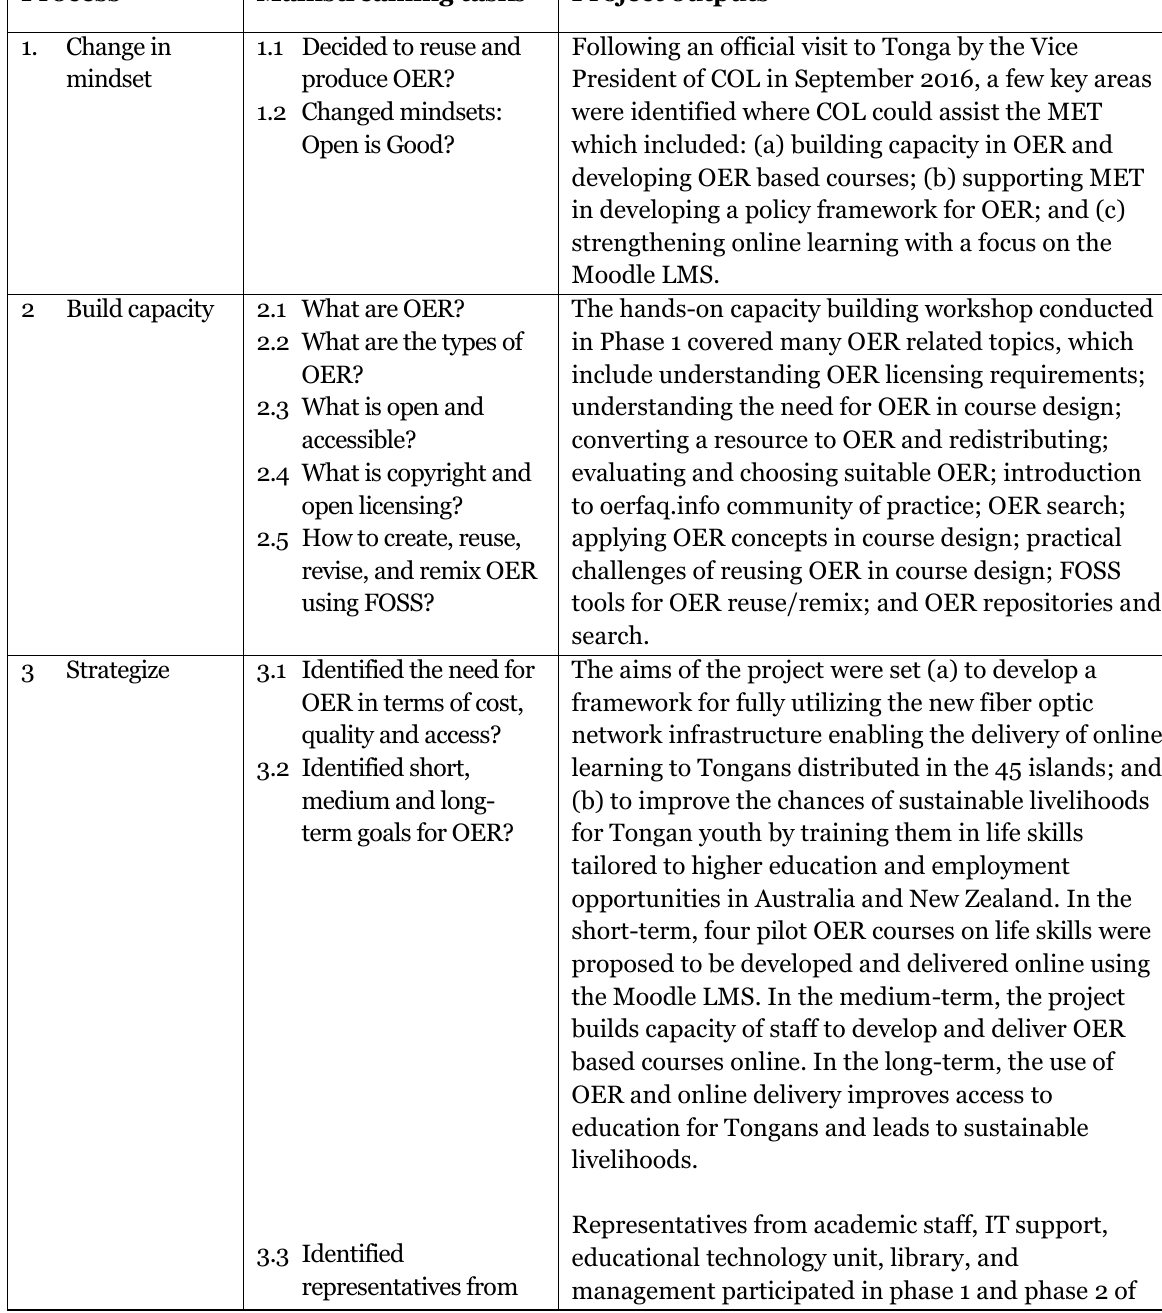
Summary of Project Outputs from Phase 1 and Phase 2 Against the Mainstreaming Checklist